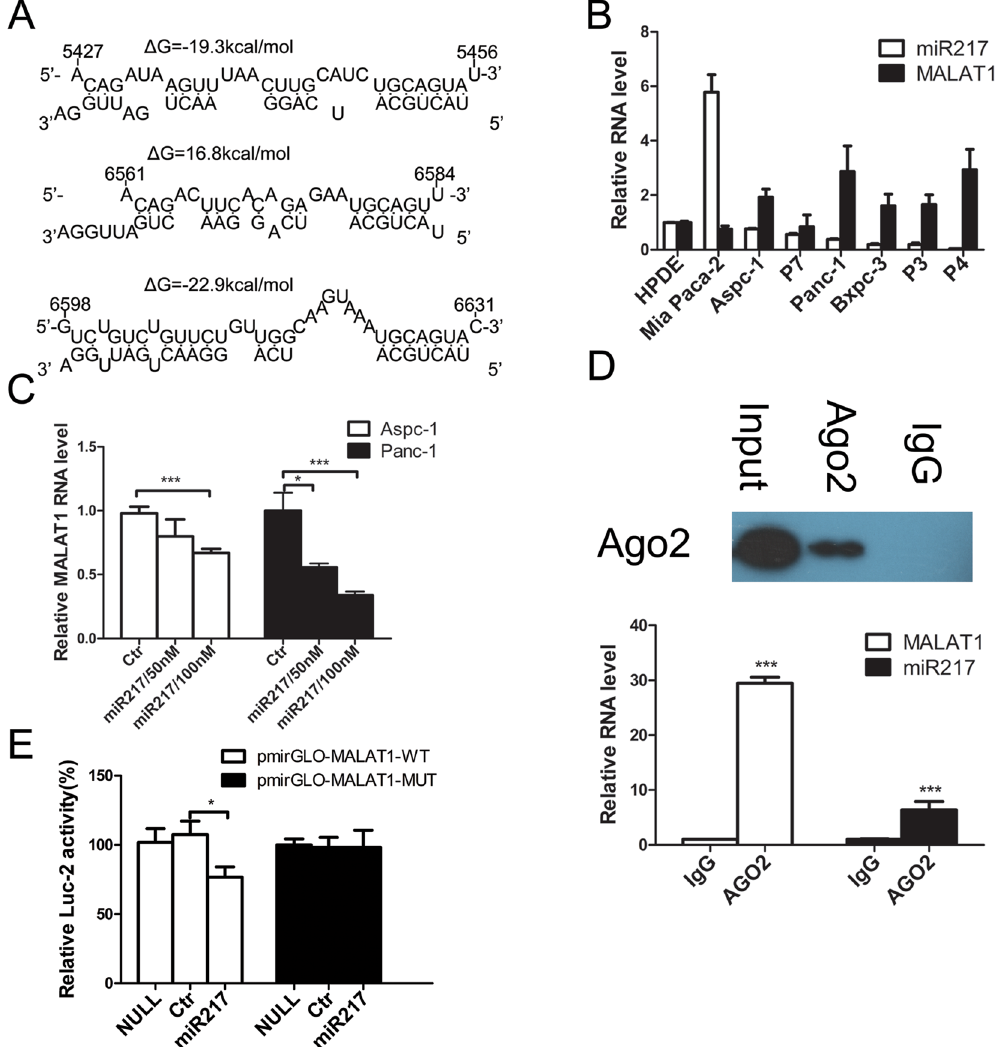
Figure 5. MALAT1 is negatively regulated by miR-217 in pancreatic cancer. ( A ) Bioinformatics analysis predicted that miR-217 binding sites were present at three distinct positions in MALAT1. The nucleotides are numbered based on their positons relative to the MALAT1 transcriptional start site. ( B ) The relative expression levels of MALAT1 and miR-217 in various pancreatic cancer cells. ( C ) MALAT1 expression in pancreatic cancer cells after transfection with an RNA mimic of miR-217. ( D ) Coimmunoprecipitation with mouse monoclonal anti-Ago2 (Ago2) or preimmune IgG from extracts of Panc-1 cells. Upper panel: Immunoprecipitation using Ago2 or IgG, followed by western blot analysis using a rabbit monoclonal anti-Ago2 antibody. Lower panel: mRNA levels in immunoprecipitates, as determined by RT-qPCR. ( E ) Luciferase reporter gene expression after pmirGLO-MALAT1-WT vectors or pmirGLO-MALAT1-MUT vectors were transfected into PDAC cells along with miR-217 or negative-control